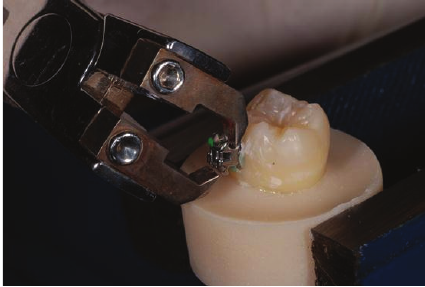
Figure 5: The sample stabilized by a vice, during the debonding.